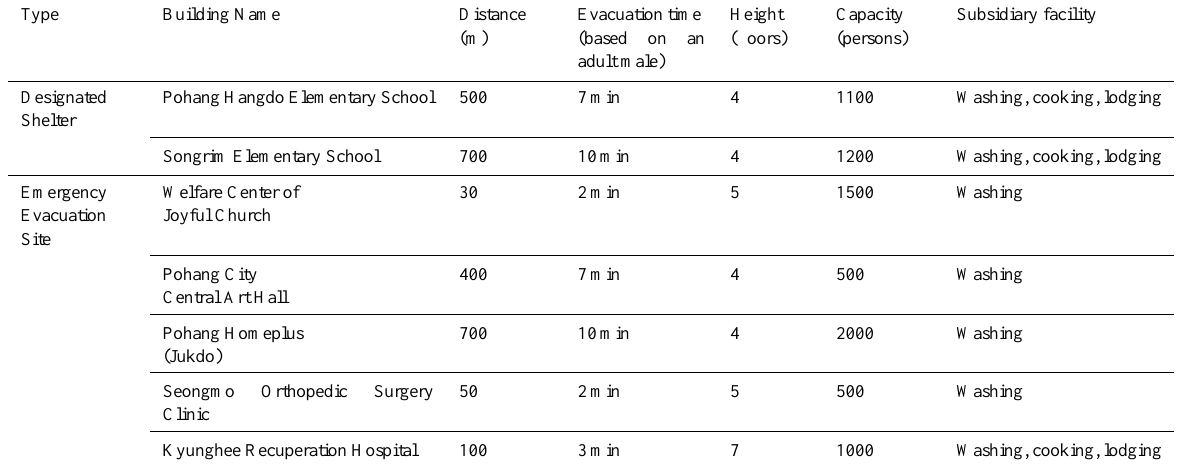
Table 3. Main information for tsunami shelters at Pohang